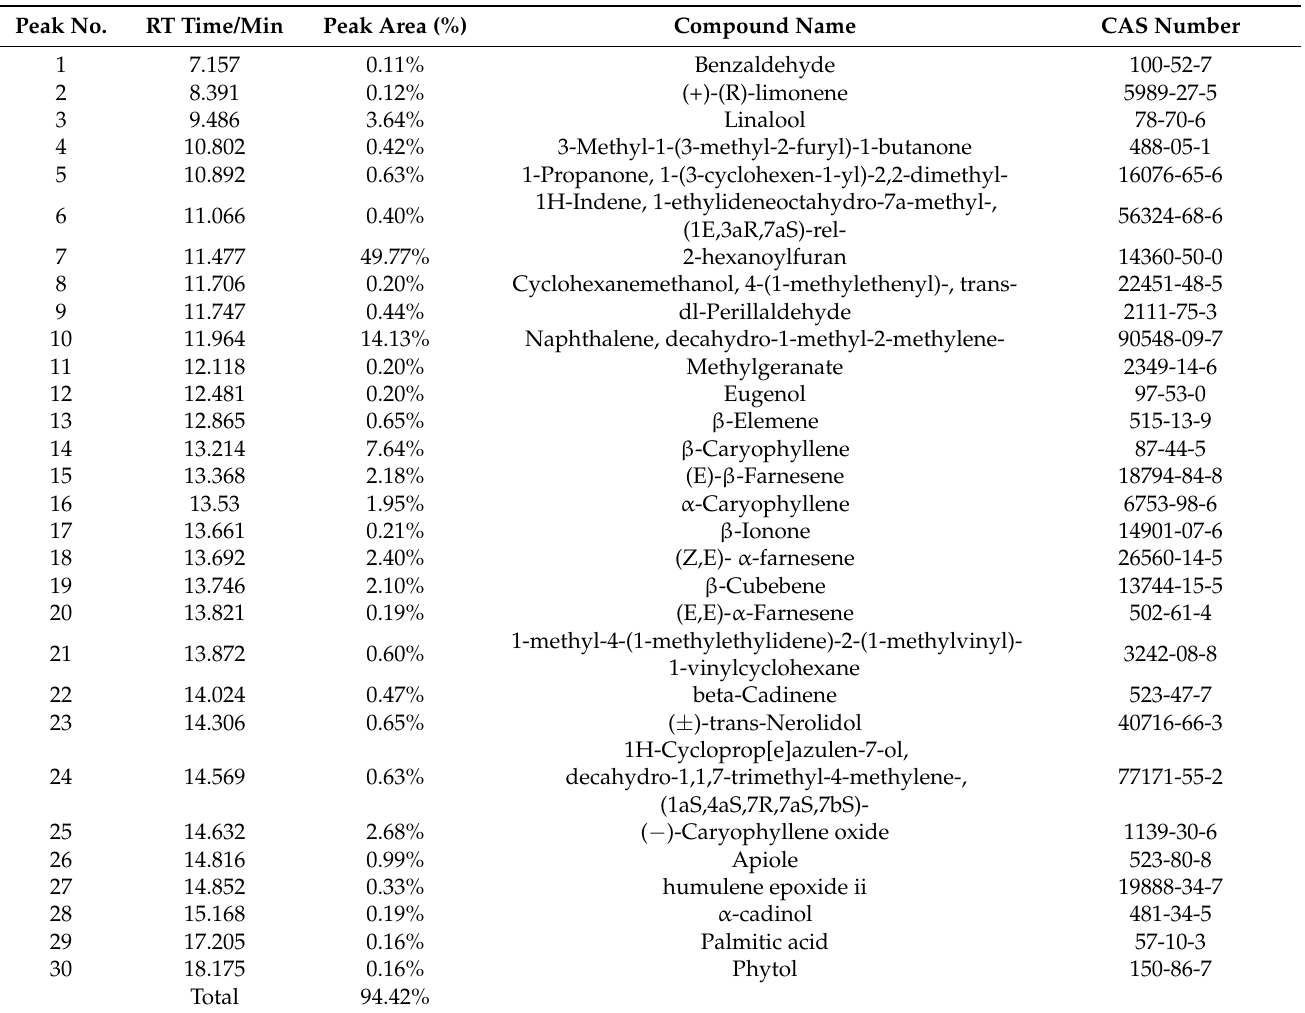
Table 1. Chemical components of the essential oil extracted from Perilla frutescens